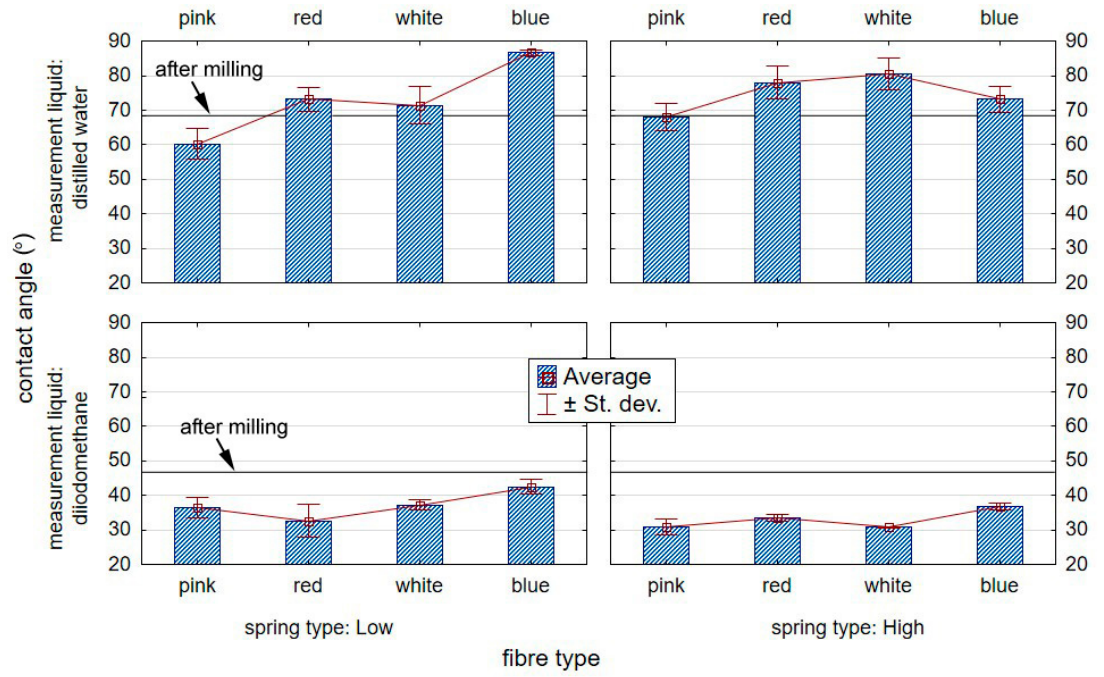
Figure 14. Effect of brushing on the value of the contact angle on the surface of an aluminium alloy.